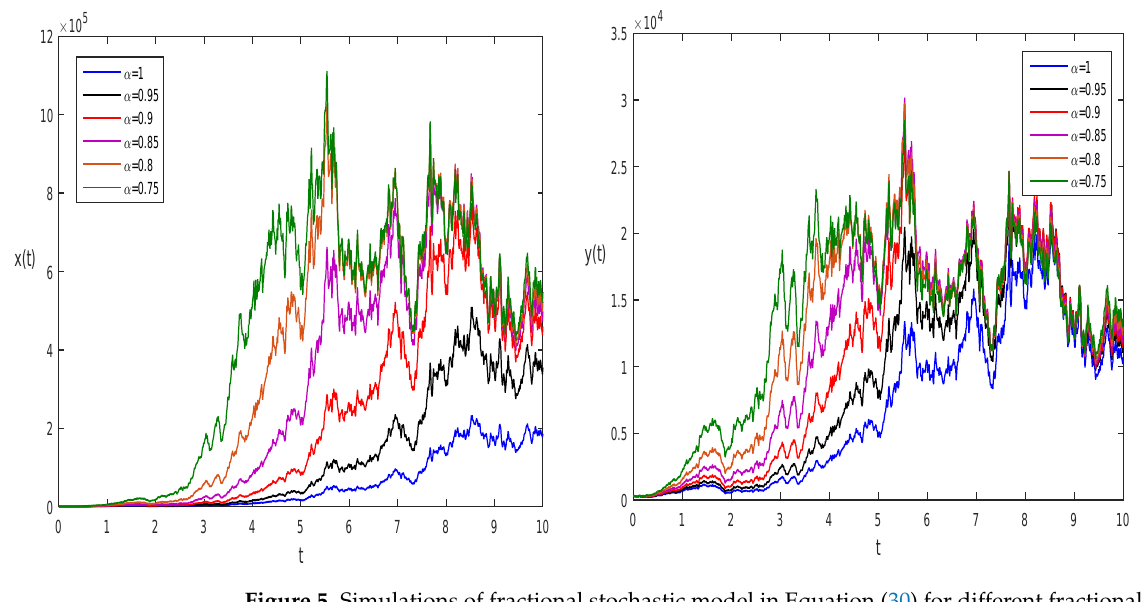
Figure 5. Simulations of fractional stochastic model in Equation (30) for different fractional parame- ter values.